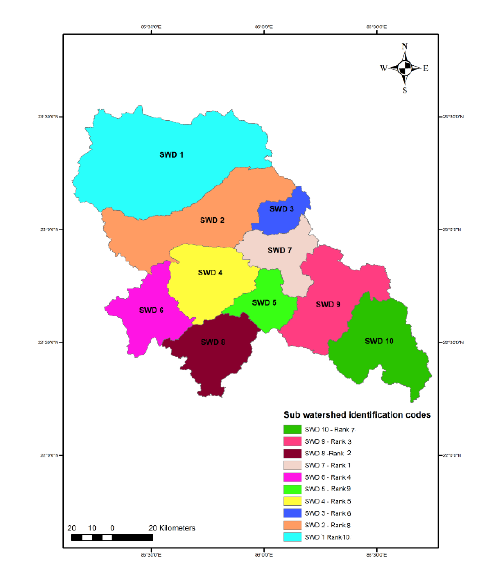
Figure 5: Subwatershed priority rank of upper watershed of River